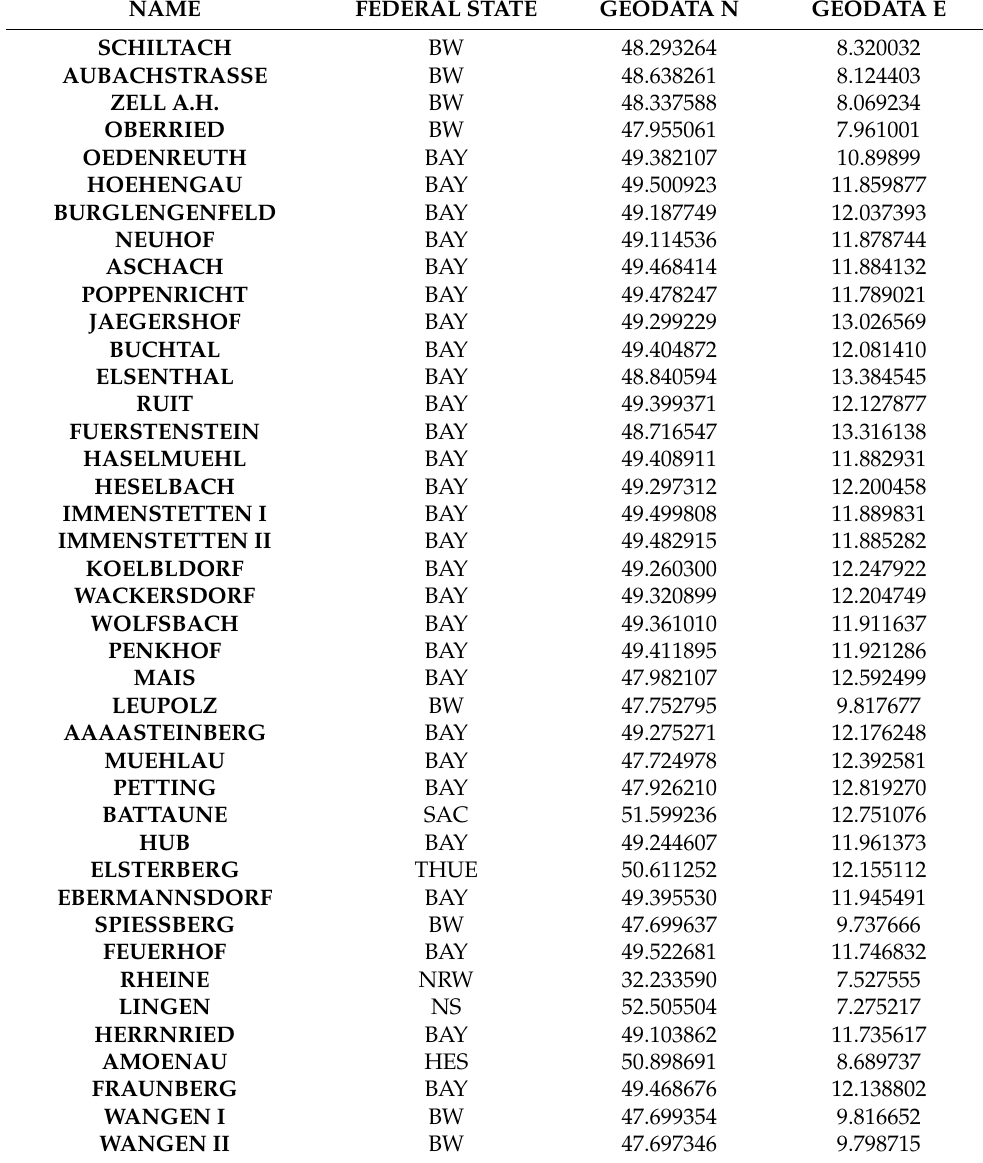
Table 1. TBEV microfoci included in our analysis . For each TBEV microfocus, geodata are refer- enced as well as the corresponding federal